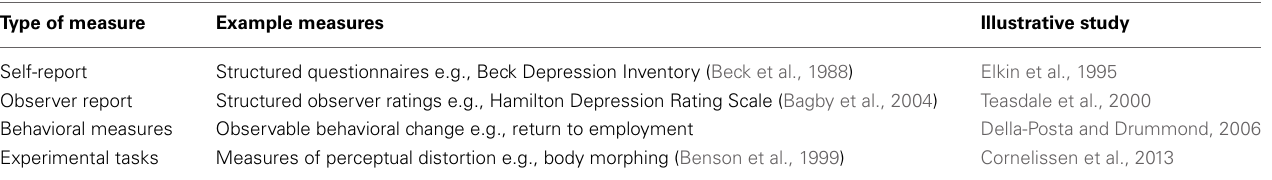
Table 1 | Indicators of consciousness used in CBT outcome